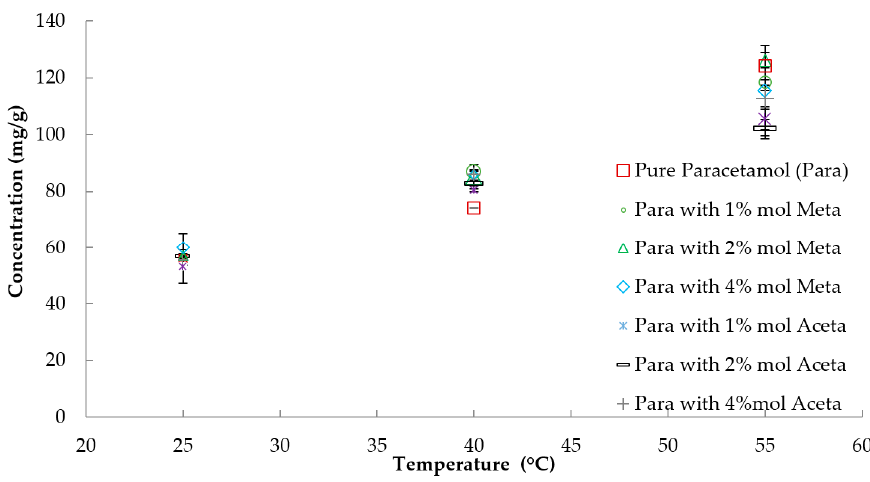
Figure 4. Solubility of paracetamol in 3-methyl-1-butanol with the presence of impurities (metacetamol and acetanilide) obtained by equilibration and gravimetric assay.